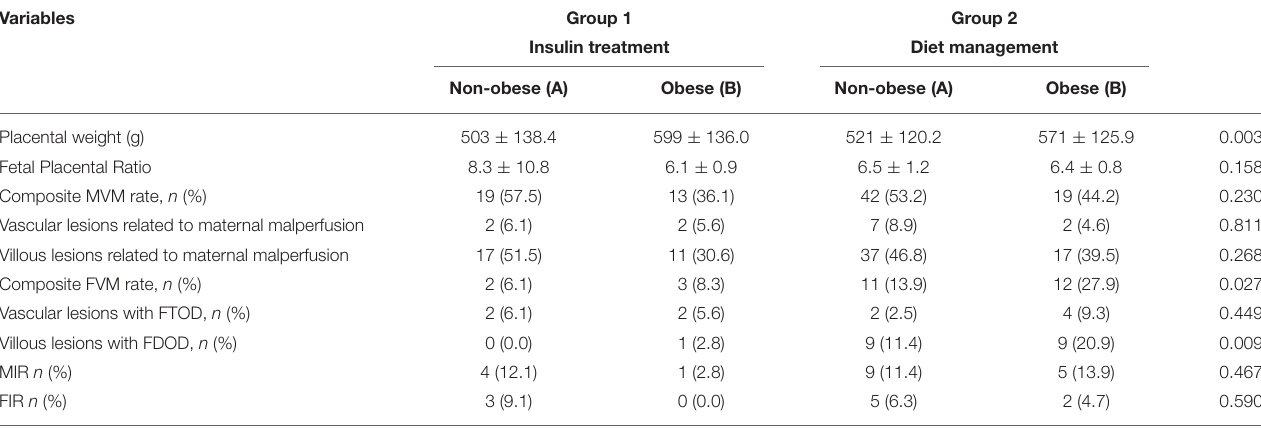
TABLE 2 | Histopathological characteristic of placenta according to the study groups.